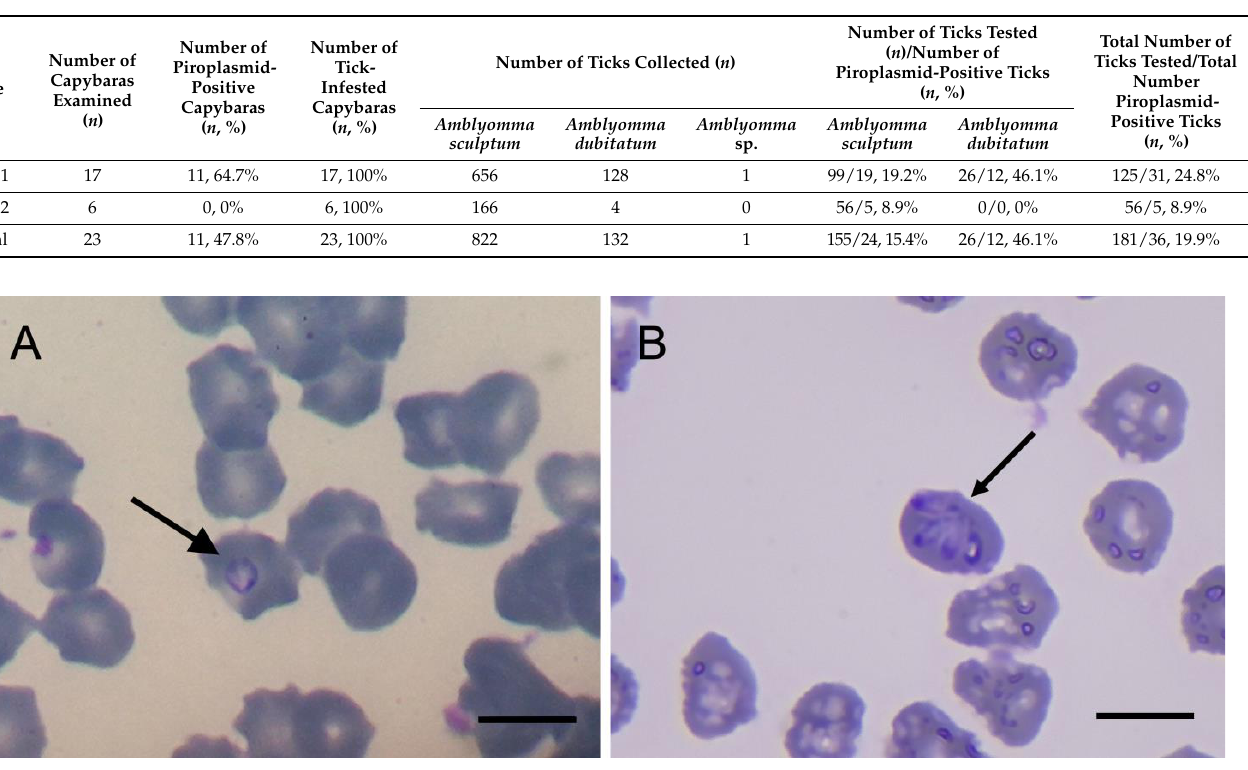
Figure 1. Intra-erythrocytic inclusions (arrowed) found in one of the infected capybaras. ( A ), a ring stage. ( B ), pyriform shape merozoites (note: the whitish structure over one of the parasites is a staining artifact). Scalebars = 10 µ